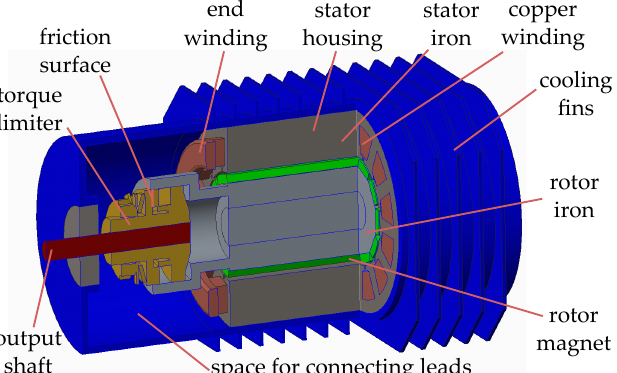
Figure 20. Integrated torque limiter with axial engagement at drive end of shaft.